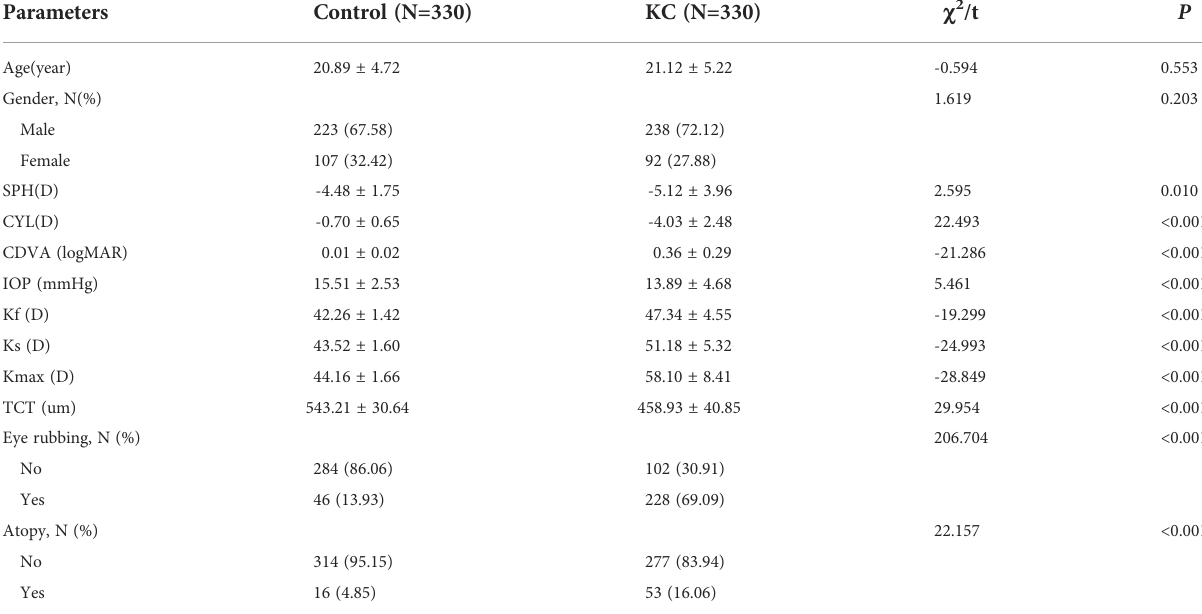
TABLE 1 Demographic data in control and KC eyes.